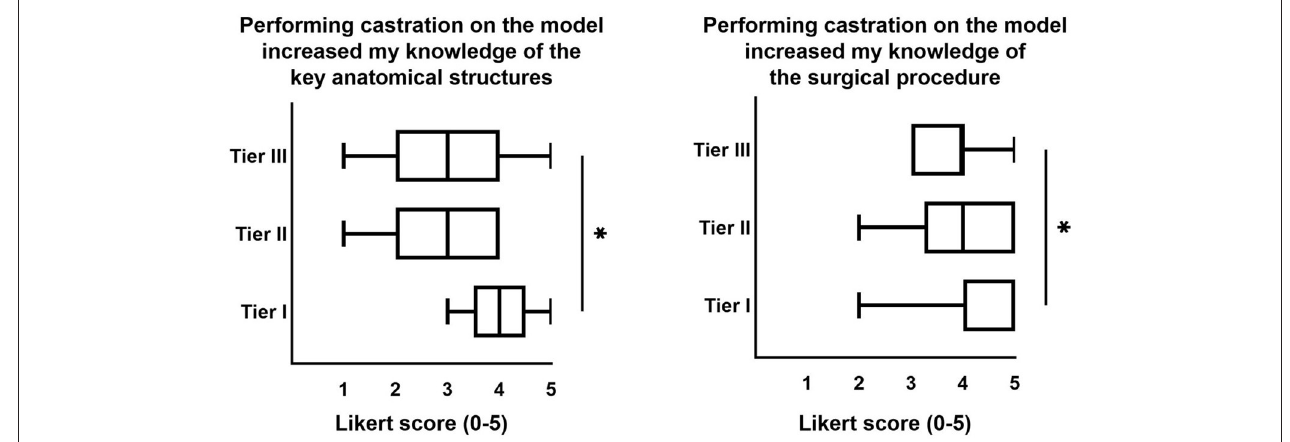
FIGURE 4 | Significant differences in Likert score model ratings in students with different levels of castration experience, prior to live horse castration. Heading is the text taken from the survey prompt. Data are presented as median and min-max. Statistical analysis performed with Kruskal-Wallis test with Dunn’s multiple comparisons post-hoc test. * p < 0.05 indicates significant difference between Tier I (no prior castration experience) and Tier III (3 or more testicles previously castrated).